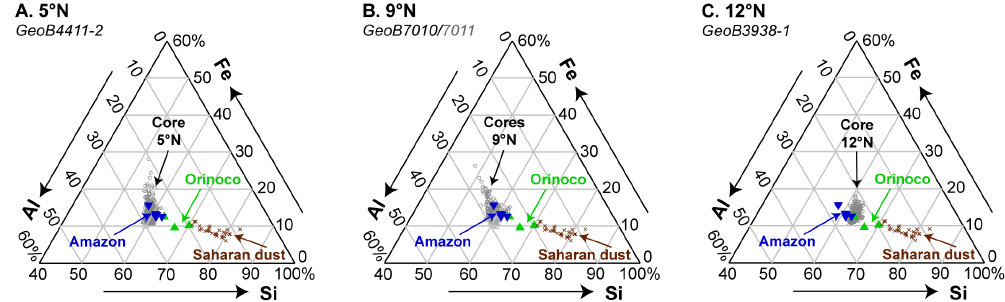
Fig. 4. Ternary diagrams highlighting the main sources of terrigenous material in the cores investigated in this study: (A) GeoB4411-2 (5 ◦ N), (B) GeoB7010/7011 (9 ◦ N) and (C) GeoB3938-1 (12 ◦ N). The relative Al, Fe and Si proportions are presented for all core samples (grey circles), Amazon (blue inverted triangles) and Orinoco (green triangles) river suspended material (see Table S3 in the Supplement for references) and Saharan dust (samples from Collins et al., 2013) for